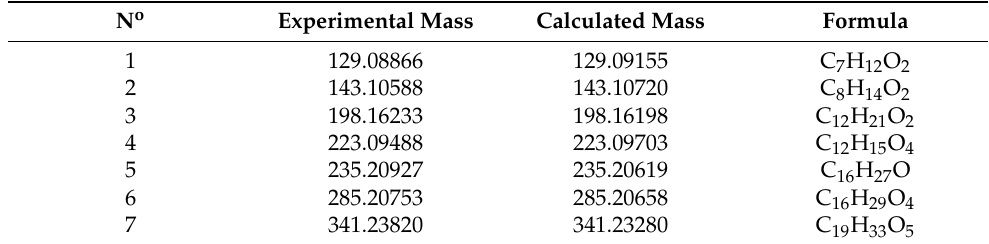
Table 6. Principal fragments obtained by the isothermic decomposition of PCL. N o Experimental Mass Calculated Mass